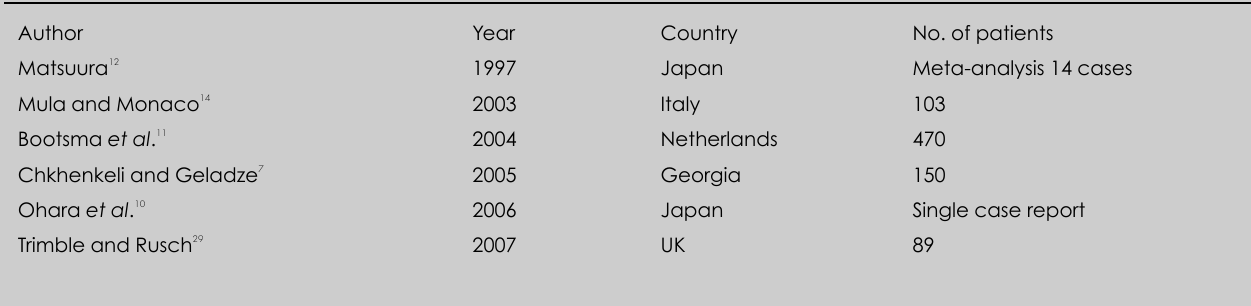
Table II. A list of published case reports and case series on forced normalisation/alternative psychosis